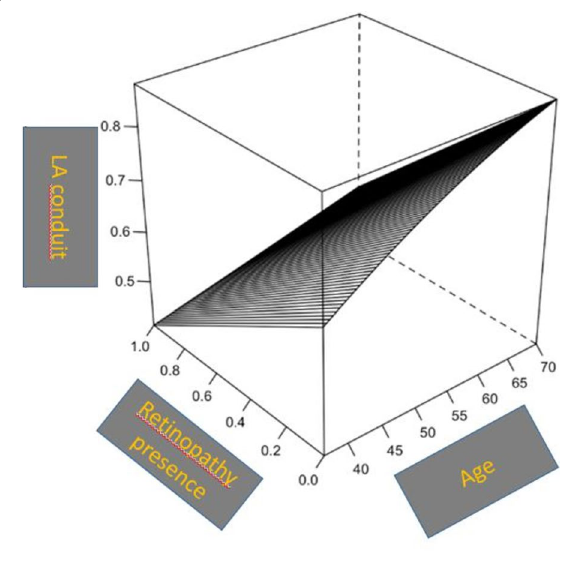
Fig. 1 Three-dimensional plot for predicting LA conduit function according to DR presence and